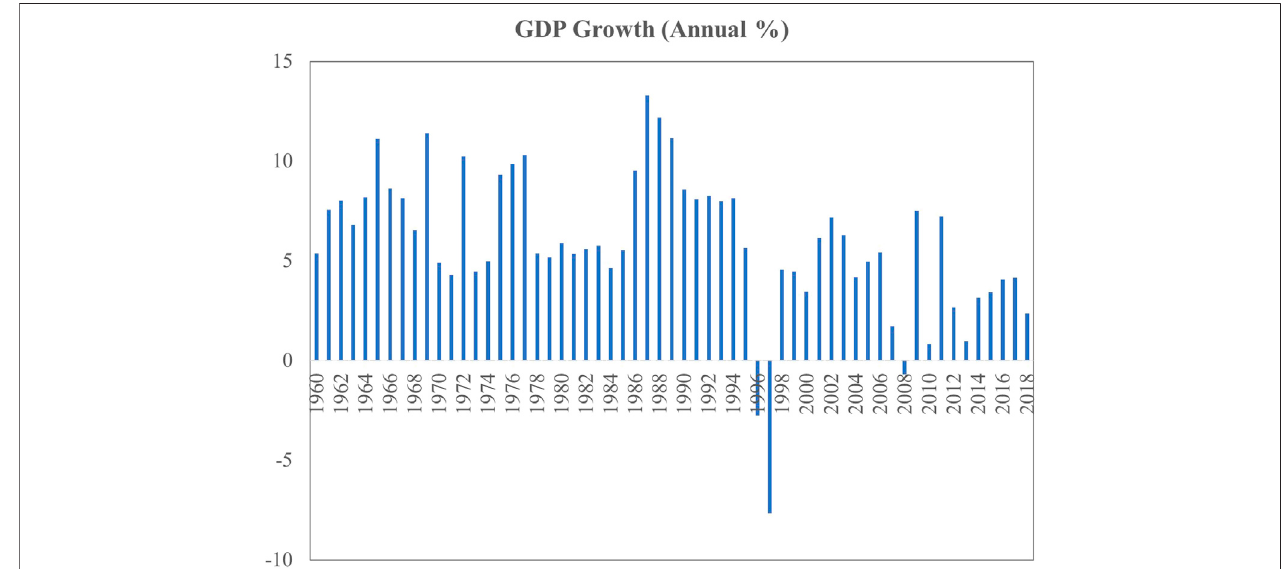
FIGURE 7 | Thailand GDP growth (World Bank,